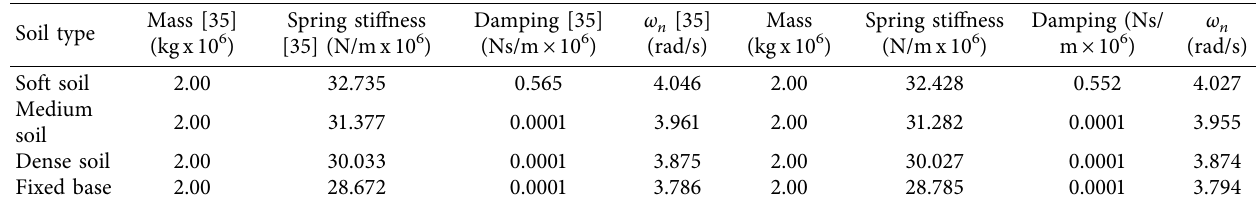
Figure 3: The flowchart of genetic algorithm. (a) The flowchart of traditional genetic algorithm. (b) The flowchart of improved multi- population genetic algorithm. Table 3: The optimized TMD parameters.